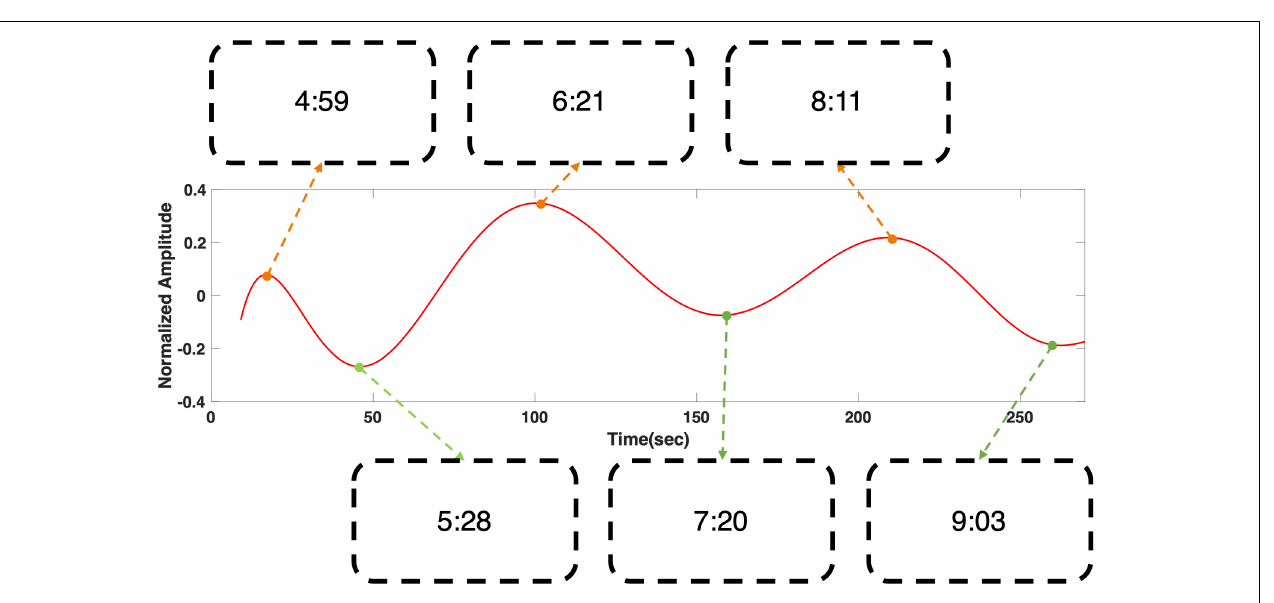
FIGURE 5 | Grand averaged polynomial regression result of SSVEP response at 6 Hz during “nervous” movie screening. The minima corresponded to the scenes that play a role in connecting the events to proceed the story, while the maxima corresponded to the scenes in which a boy was loading or triggering a gun. The scenes corresponding to each local extrema can be found using the time stamps in the boxes. The time stamps correspond to the time points in the following movie clip: